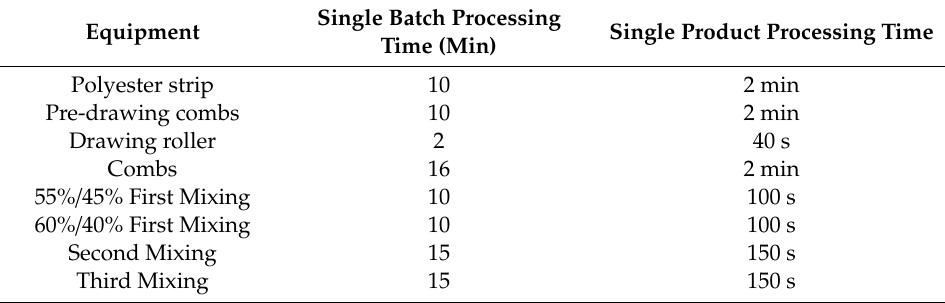
Table 8. Equipment processing time.